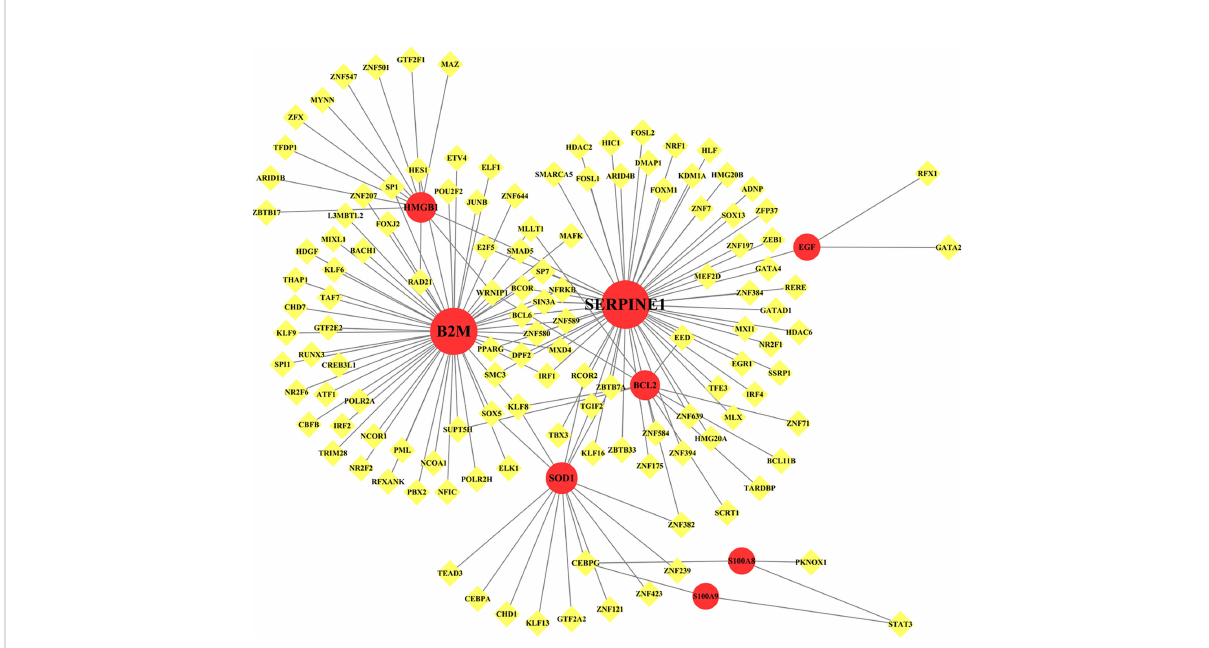
FIGURE 7 Network for TF-gene interaction with common differentially expressed genes. The highlighted red color node represents the common genes and other nodes represent TF-genes. The network consists of 136 nodes and 156